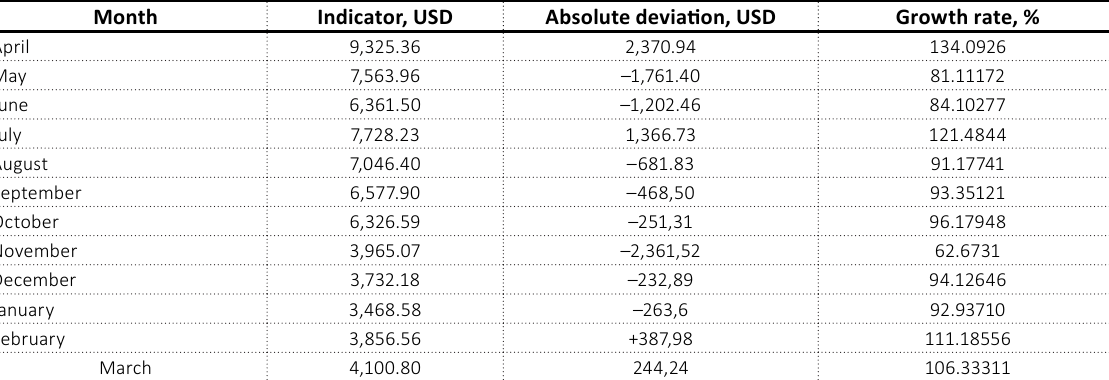
Table 2. Bitcoin rate (April 2018 – April 2019)